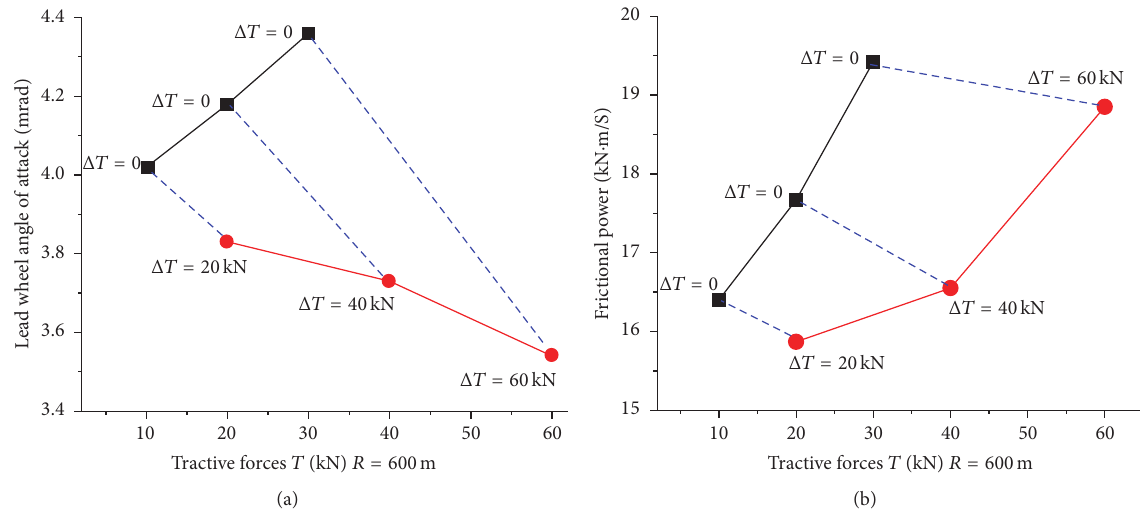
Figure 8: Δ𝑇 influence on guiding performance, (a) Δ𝑇 -dependence changing curve of lead wheel angle of attack and (b) Δ𝑇 -dependence changing curve of total vehicle friction